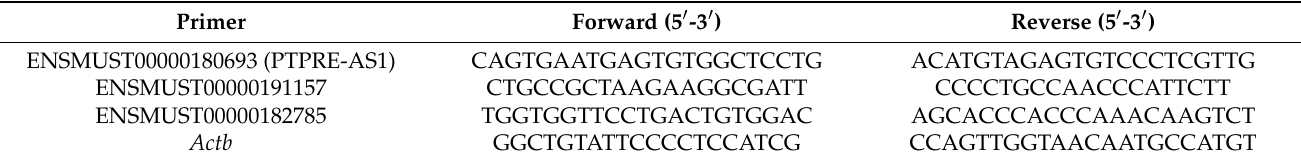
Table 1. Quantitative real time PCR